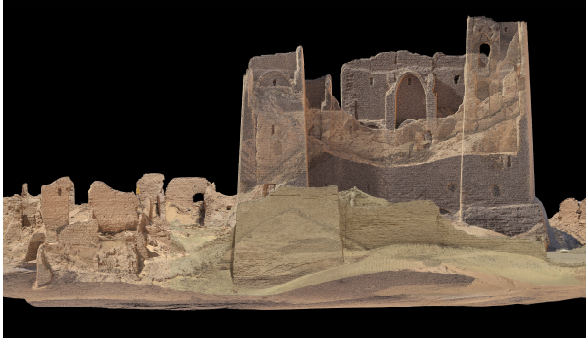
Figure 5. Orthoimage of the external façades of the castle. In transparency the internal areas. It is clearly possible to study the level of internals remains and buildings techniques.